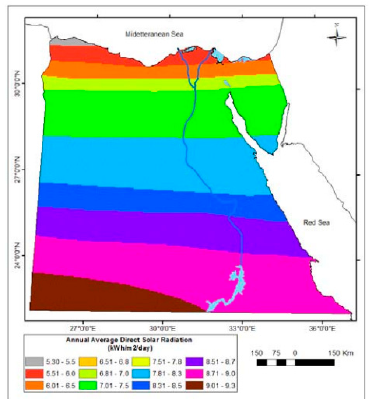
Figure 6. The schematic of solar radiation from the Atlas of Egypt, 1991.